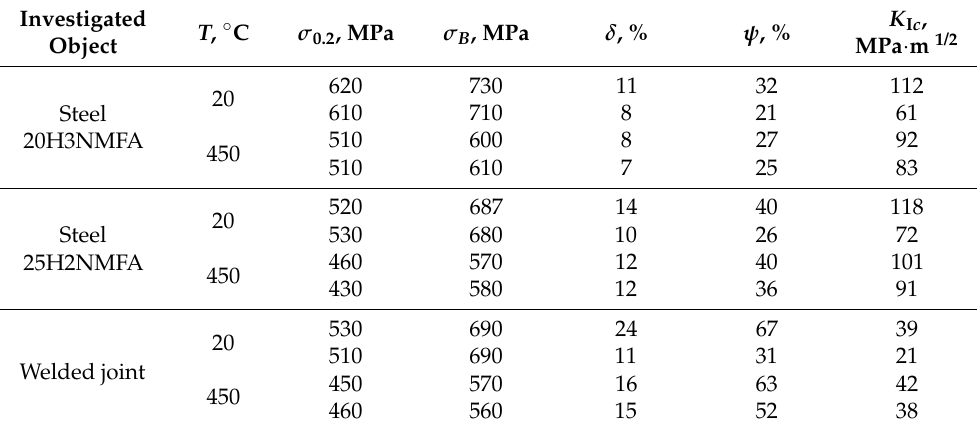
Table 4. Mechanical properties of welded joints in air (upper value) and in hydrogen at a pressure of 10 MPa (down